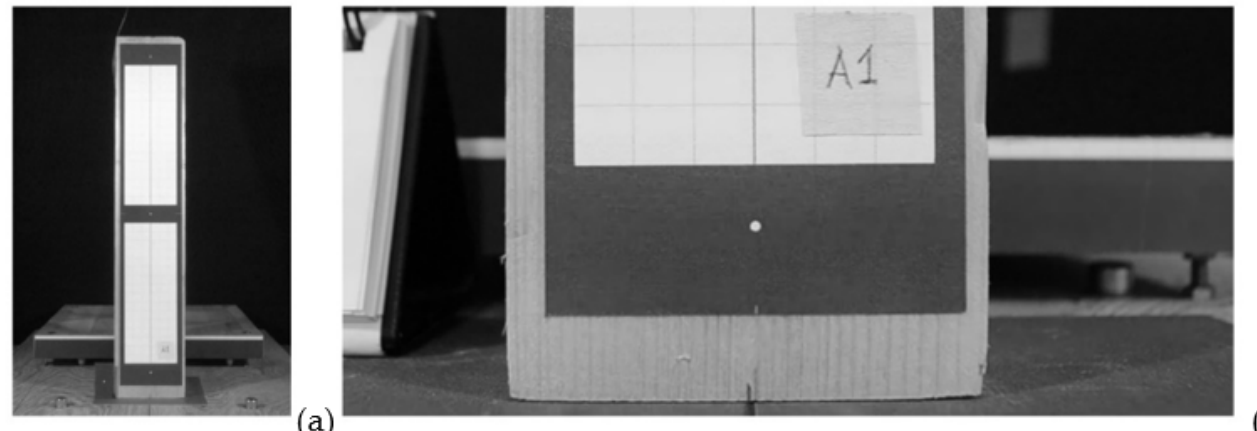
Figure 6. Specimen preparation: ( a ) vertically aligned high contrast circular points and ( b ) detailed view.